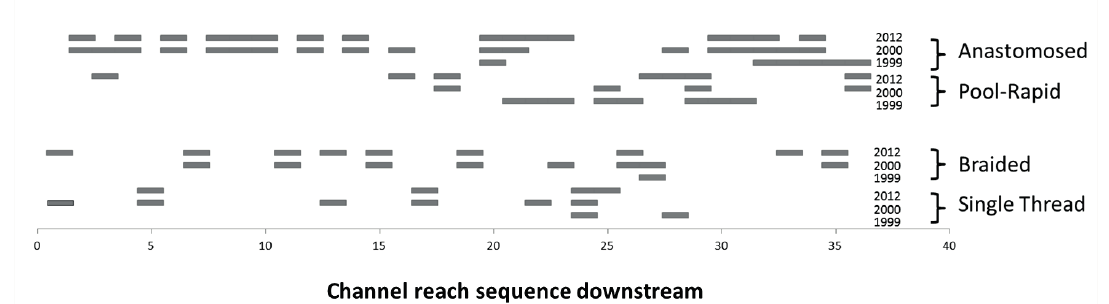
Fig. 2 Channel type change over a 106 km length of the Sabie River in response to the cyclone-driven floods of 2000 and 2012. The ‘anastomosed’ category includes both bedrock anastomosed and mixed anastomosed types (note shorter study reach in